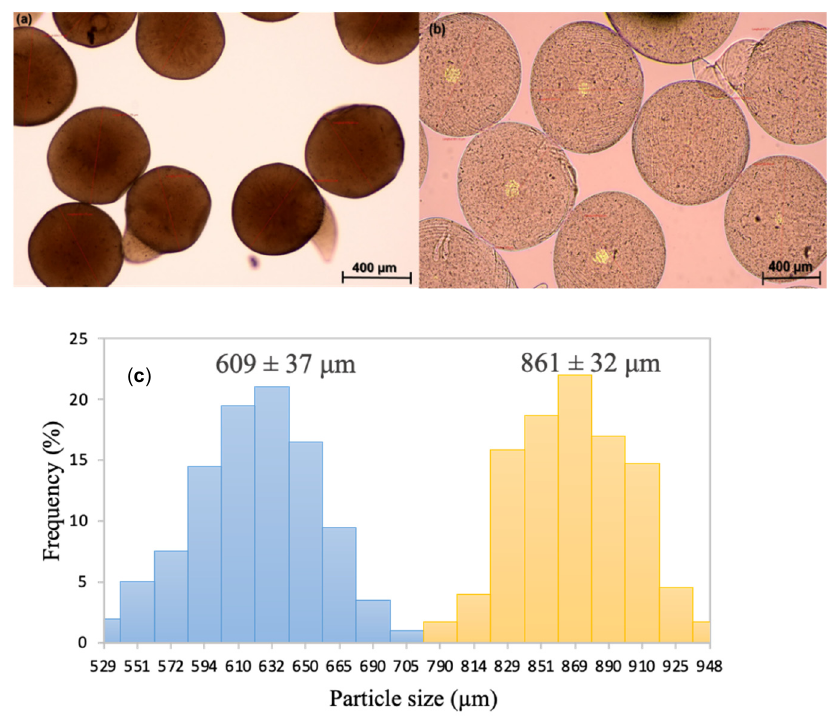
Figure 2. Optical images of 0.75% ( w/v ) alginate (crosslinked in 0.8 M CaCl 2 baths) ( a ) aerogels and ( b ) hydrogels obtained by inkjet printing, with ( c ) the particle size distribution (in number) of aerogels (blue) and hydrogels (yellow), respectively.